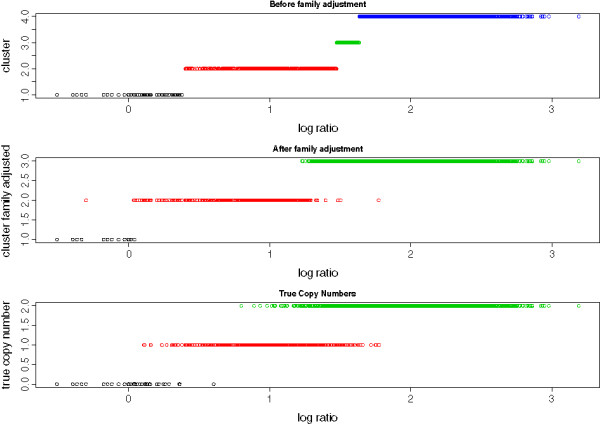
Simulation: Before and after family adjustment. The raw intensity values and CNV calls from the same simulated CNV regions in Figure 1. The colors denote the clusters from Gaussian mixture models (Top) and Family adjustment algorithm (Middle). The bottom panel shows the real copy numbers from which the intensity data were generated.